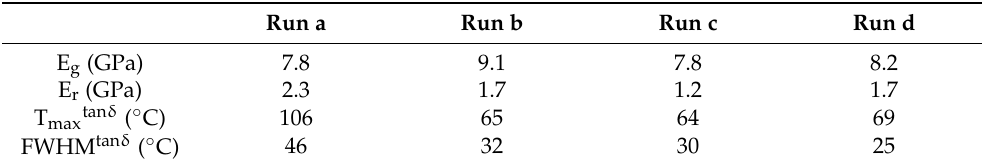
Figure 1. Changes in the storage modulus ( left ) and tan δ ( right ) monitored for Run a , Run b , Run c and Run d . Table 1. Storage moduli measured at the glassy plateau (E g ) and rubbery plateau (E r ), maximum temperature T maxtan δ and the full width at half maximum (FWHM) of the tan δ